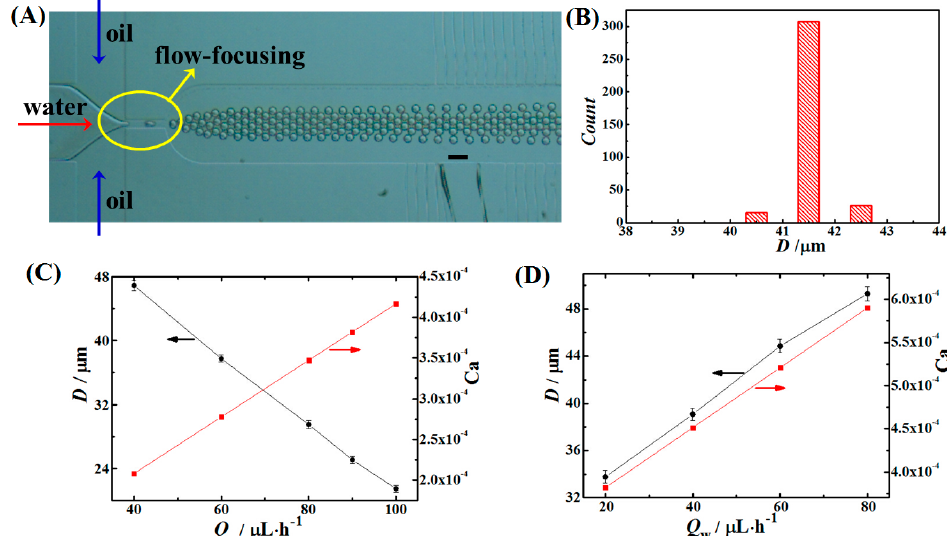
Figure 2. ( A ) An optical microscopic image of the microdroplets generation in a PDMS-based flow-focusing microfluidic device. The scale bar is 100 μ m. ( B ) The size distribution of the microdroplets generated in the device ( A ). The average diameter of the microdroplets was 41.5 μ m with the coefficient of variation (CV) 0.7%. In ( A ) and ( B ), the highly uniform microdroplets were generated in the device with w f = 50 μ m. ( C ) The microdroplets diameter changed with Ca and Q o in dripping region when Q w was fixed at 20 μ L·h − 1 . Q o was varied from 40 to 100 μ L·h − 1 . ( D ) The microdroplets diameter changed with Ca and Q w in dripping region when Q o was kept constant at 90 μ L·h − 1 . Q w was varied in the range of 20–80 μ L·h − 1 . In ( C ) and ( D ), these monodispersed microdroplets were obtained in the device with w f = 25 μ m. The oil phase and water phase were hexadecane with 2.7% ( w/v ) Span 80 and DI water, respectively.